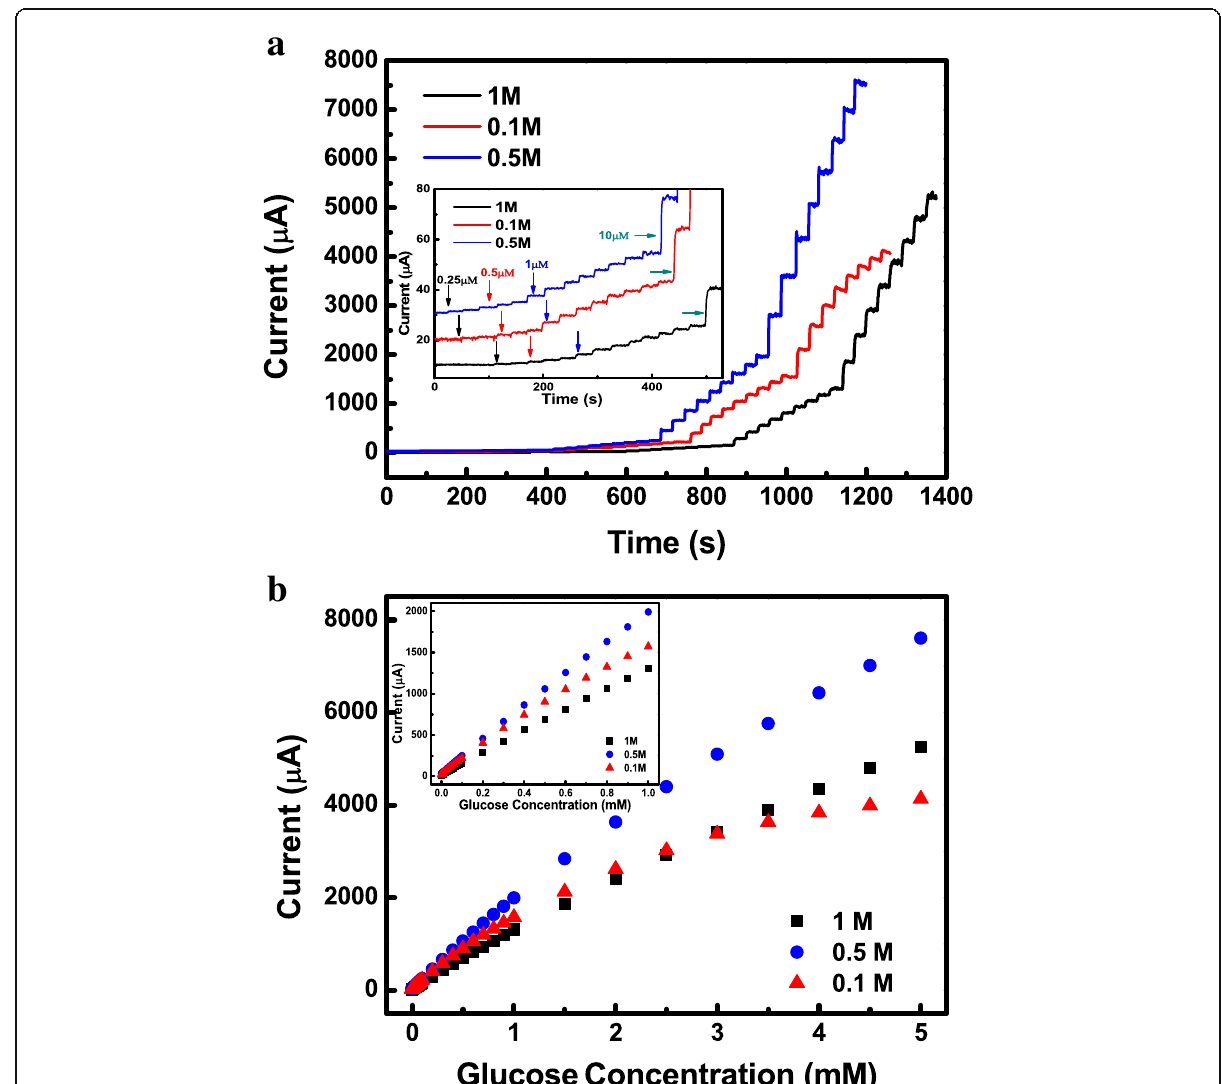
Fig. 5 Current response to glucose in different concentrations of NaOH. The current-time response ( a ) and current- C glucose curves ( b ) for Co-Ni hydroxide electrode acquired in 0.1 M, 0.5 M, and 1 M